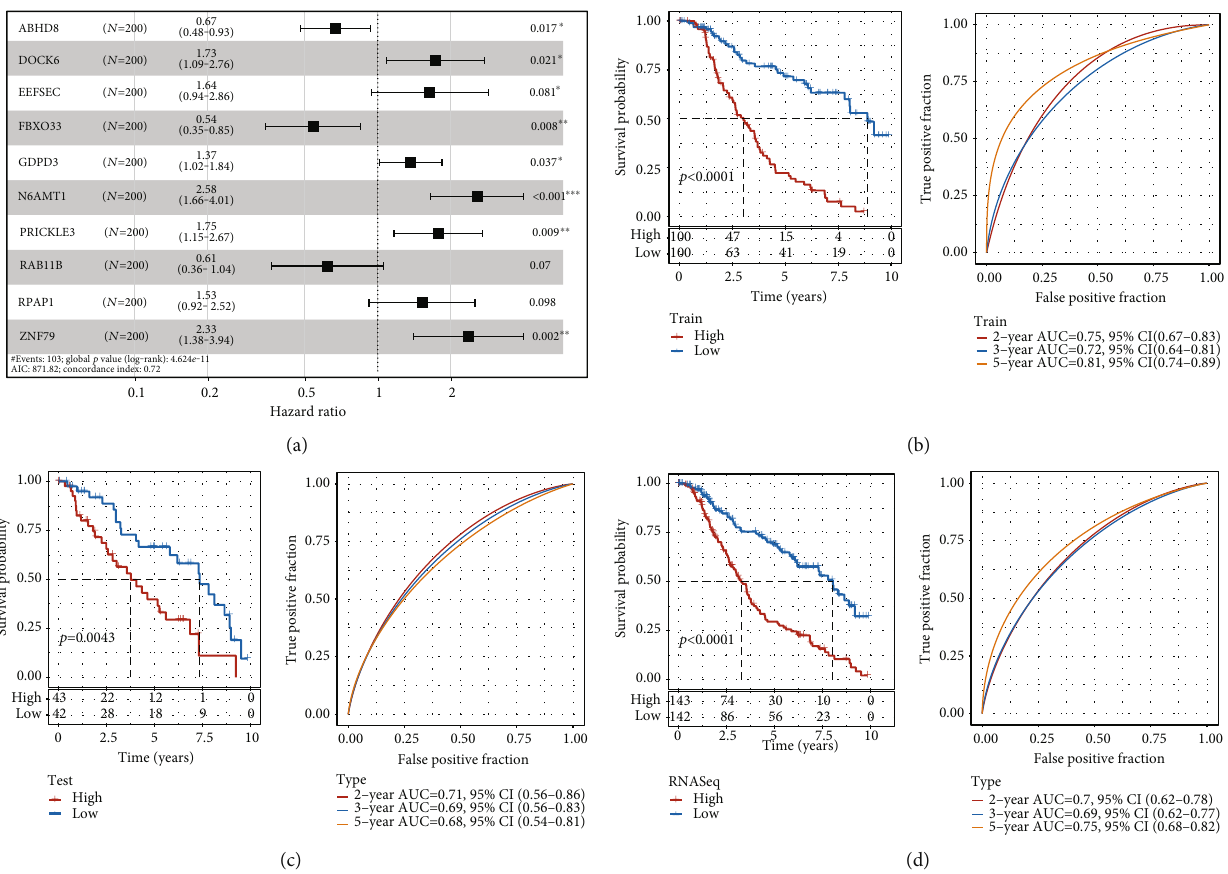
Figure 6: Clinical prognostic model development and examination. (a) Multivariate Cox regression-based forest map of model genes in RNAseq data set. (b) ROC and the KM survival curves depicting NPRS in RNAseq training queue. (c) ROC and KM survival curves depicting NPRS in RNAseq validation queue. (d) ROC and KM survival curves depicting NPRS in RNAseq